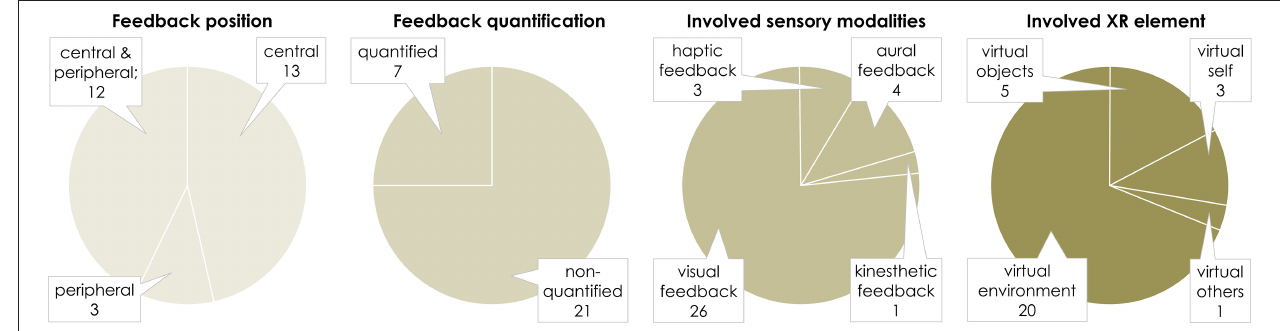
FIGURE 4 | Depiction of the different feedback types used in within the literature on XR-based mindfulness support. As not all papers included feedback and some papers included different feedback types, the numbers here do not match the total number of papers.